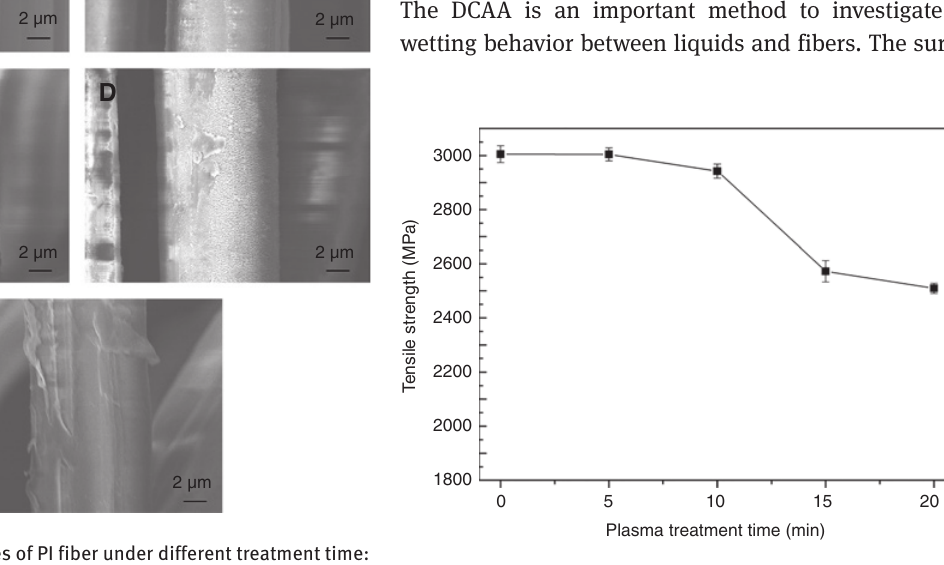
Figure 3: Tensile strength of the polyimide fiber.